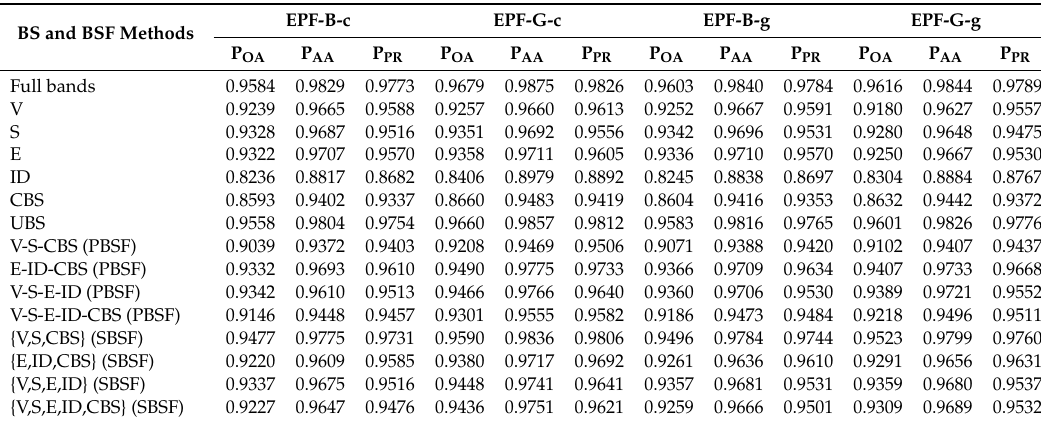
Figure A4. Ground-truth of the University of Pavia scene with nine classes